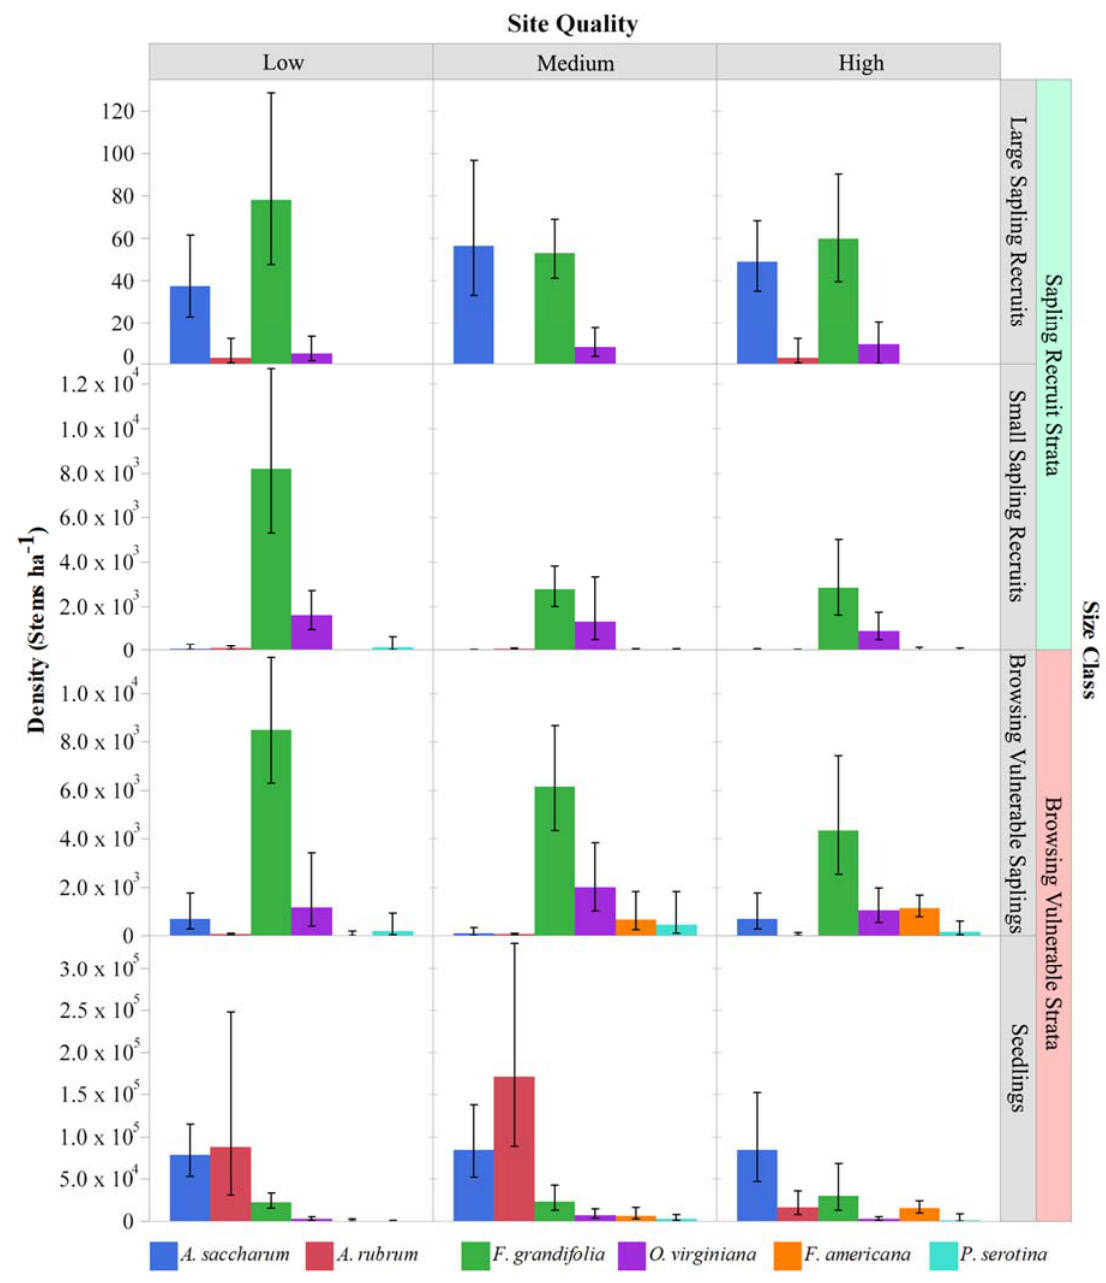
Figure 3. Tree regeneration strata by species and habitat type in the NLP: See Figure 1 legend for habitat types corresponding to site quality classes. Values are model estimated means ± 95% confidence intervals. Species shown contributed > 1% of the total composition in any one site quality × size class × peninsula combination.